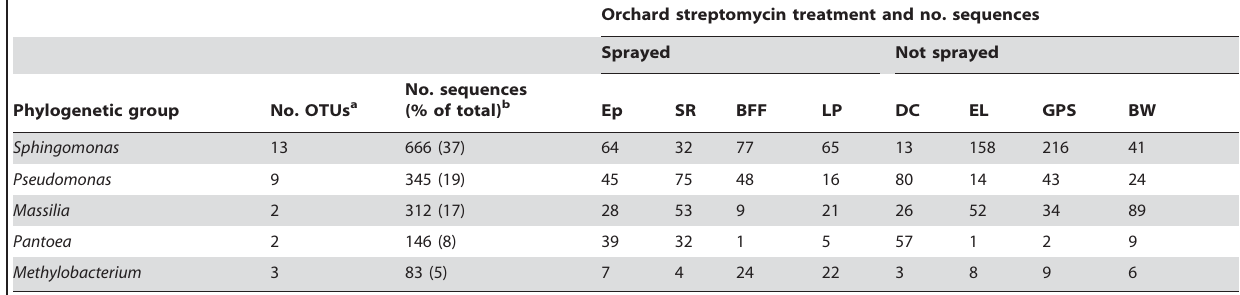
Table 5. Genera shared across all